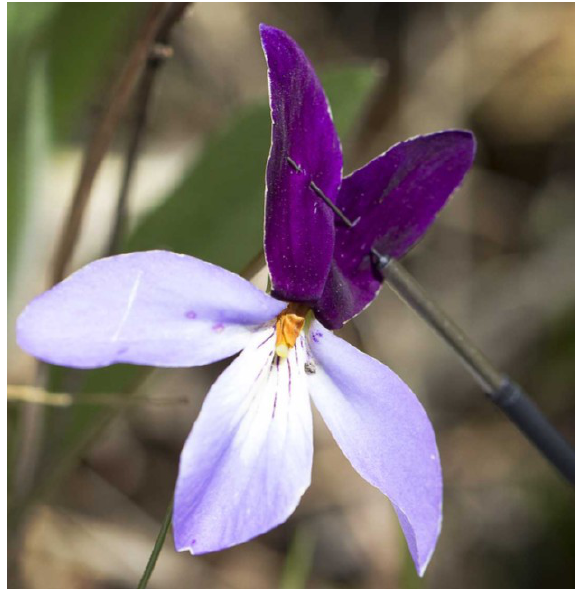
F IGURE 3. Bicolour flower of Viola pedata, with thermocoupler probe inserted through the posterior petals (R. Edens-Meier,